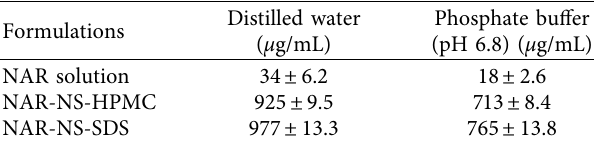
Table 2: The saturation solubility of naringenin solution (NAR) and naringenin nanosuspensions in distilled water and phosphate buffer (pH 6.8).